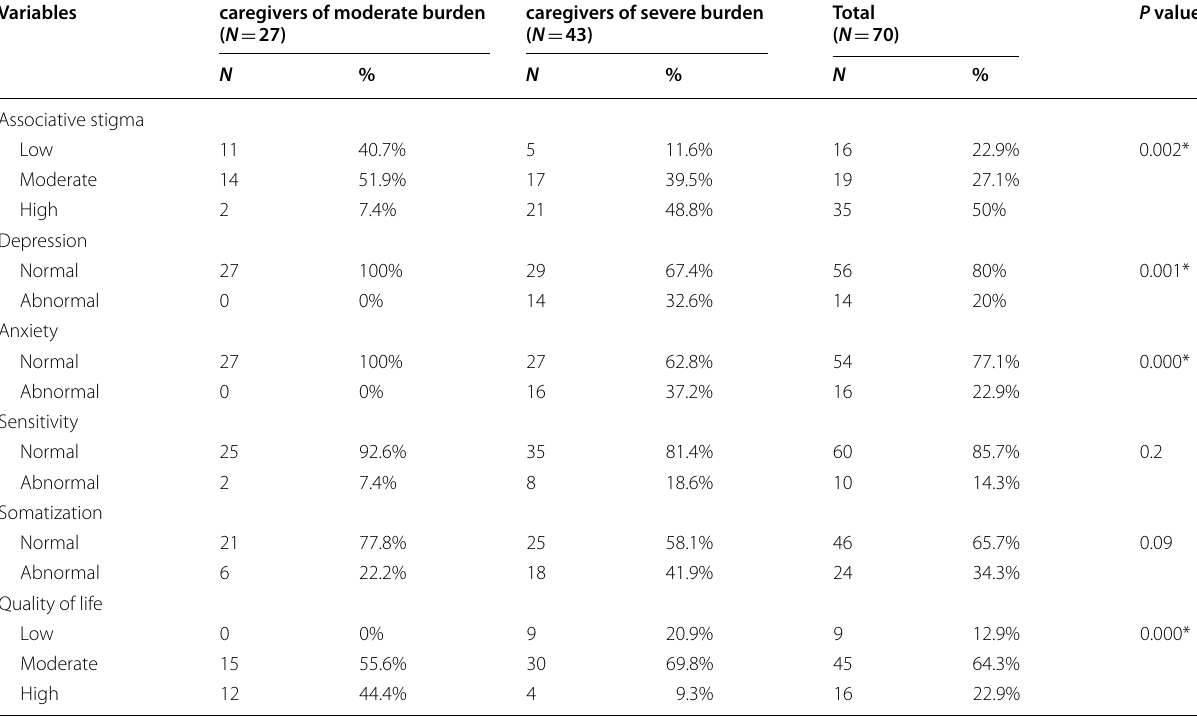
Chi squared test * Significant P value <